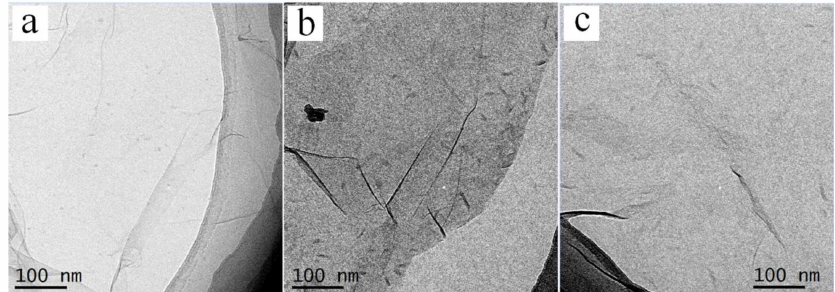
Figure 3. TEM images of PE21M/RGO nanocomposites produced in p -xylene at different temperatures for 6 h. ( a ) 40 ◦ C, ( b ) 50 ◦ C, and ( c ) 60 ◦ C (both PE21Br and RGO concentrations are 0.05 wt